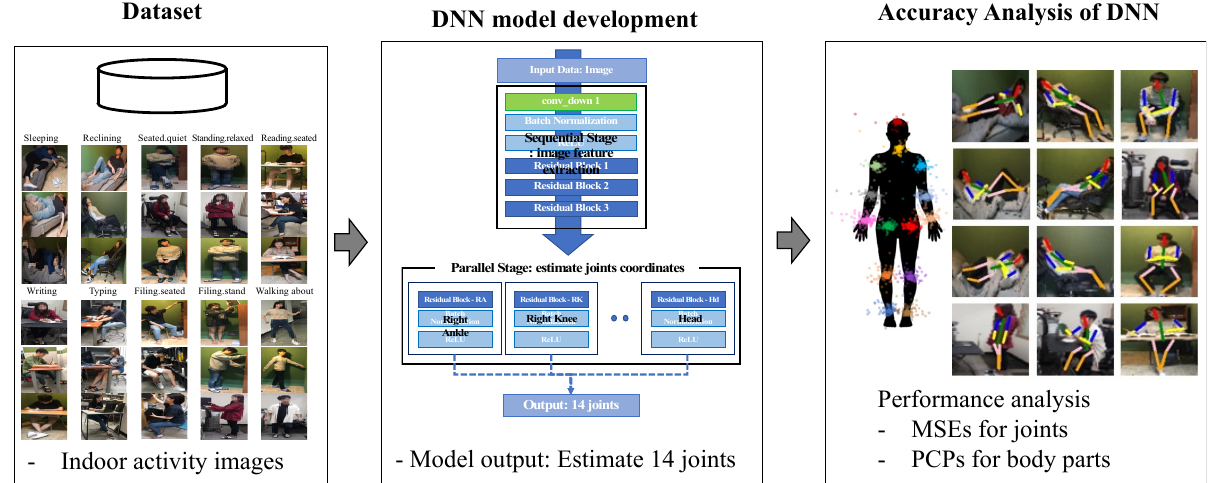
Figure 1. The activity estimation process for indoor activity images.